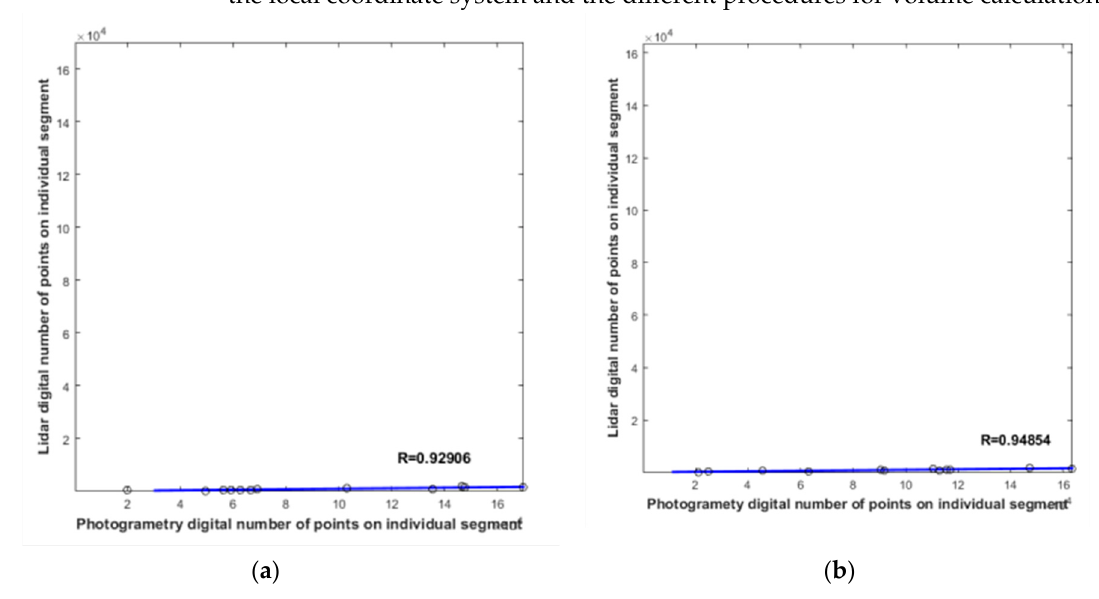
Figure 16. Correlation between the number of points (photogrammetric measurements) and the number of points (lidar measurements): ( a ) left side of canopy and ( b ) right side of canopy. The correlation was performed for all 12 segments.